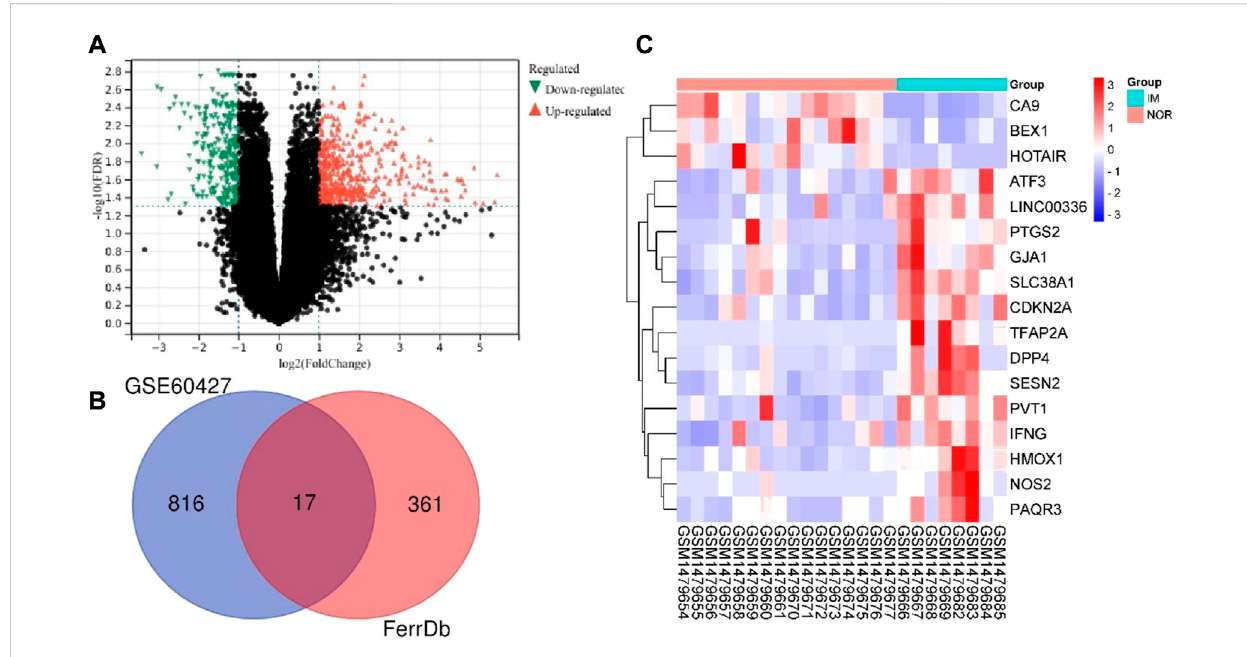
FIGURE 2 Identi fi cation differentially expressed ferroptosis-associated genes. (A) Volcano plot of DEGs of GSE60427 (red: upregulated DEGs. green: downregulated DEGs.) (B) After the intersection, 17 DEFRGs were identi fi ed based on the Venn diagram. (C) Heatmap of fi nal DEFRGs (red: high expression; blue: low